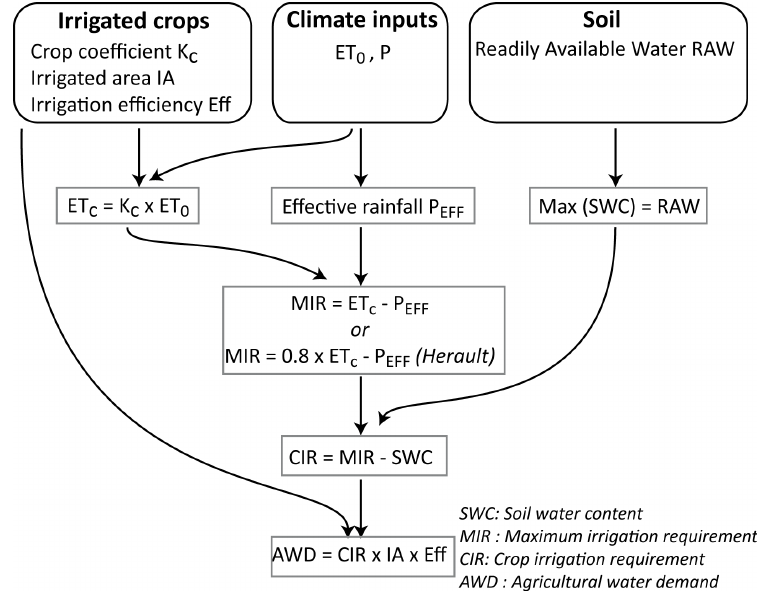
Figure 4. Agricultural water demand (AWD) simulation